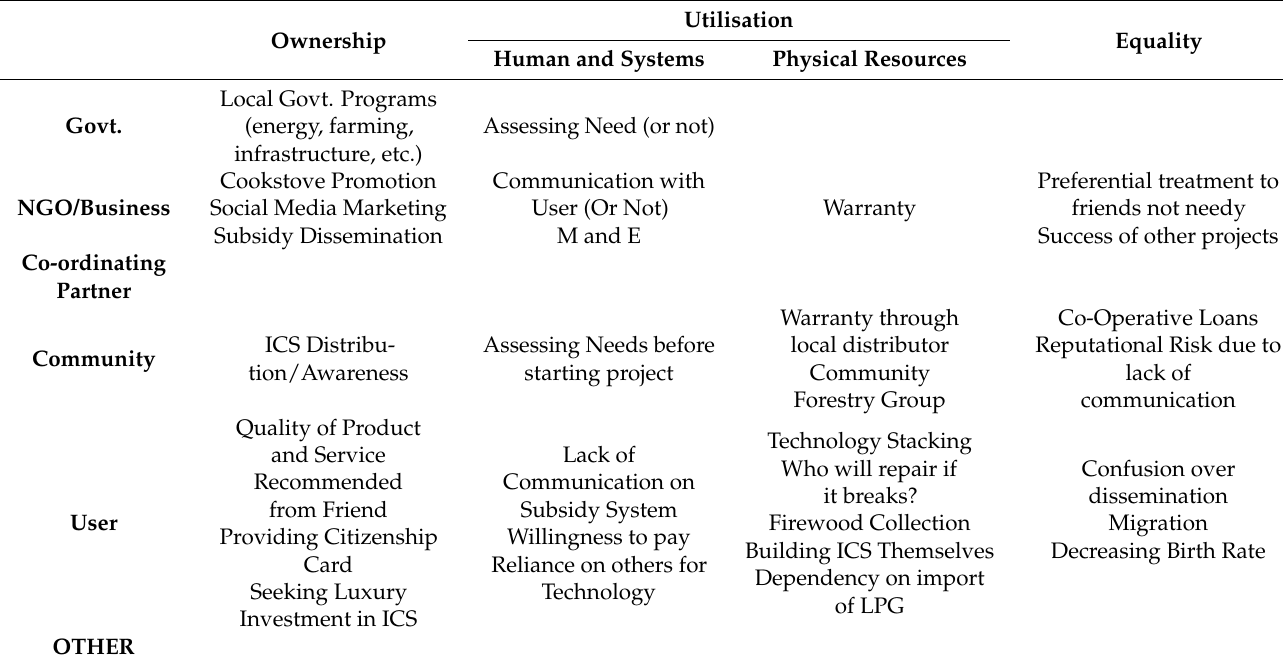
Table 6. Personal/Interpersonal EEM